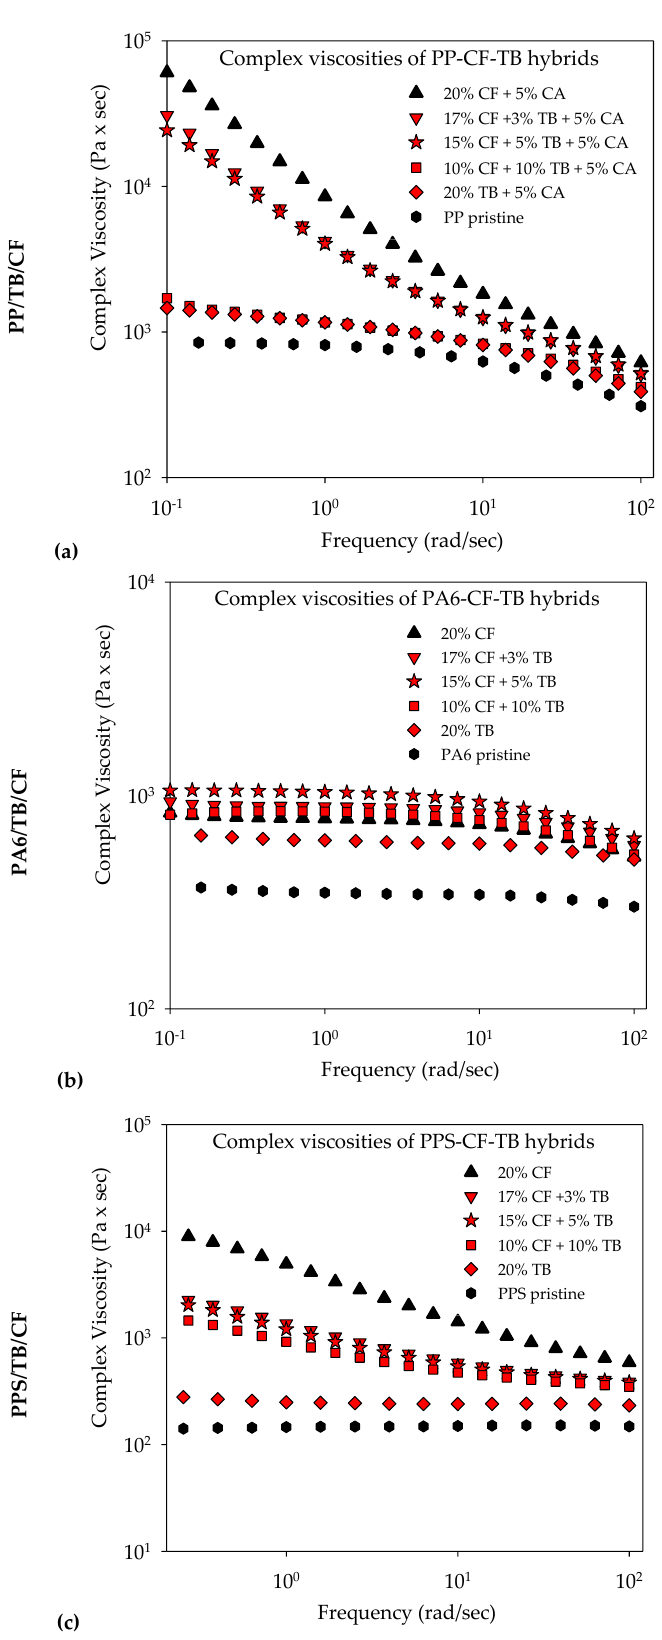
Figure 12. Viscosity curves of: ( a ) PP/TB N990/CF, ( b ) PA6/TB N990/CF, and ( c ) PPS/TB N990/CF hybrids.